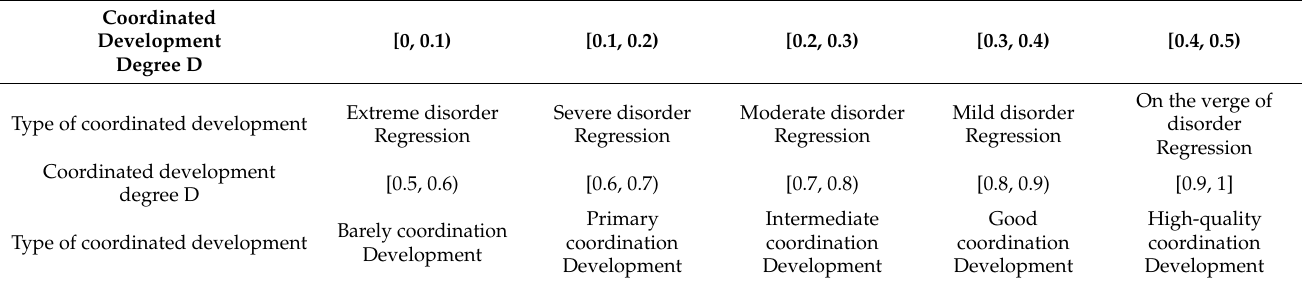
Table 2. Classification system and grading standard of coordinated development